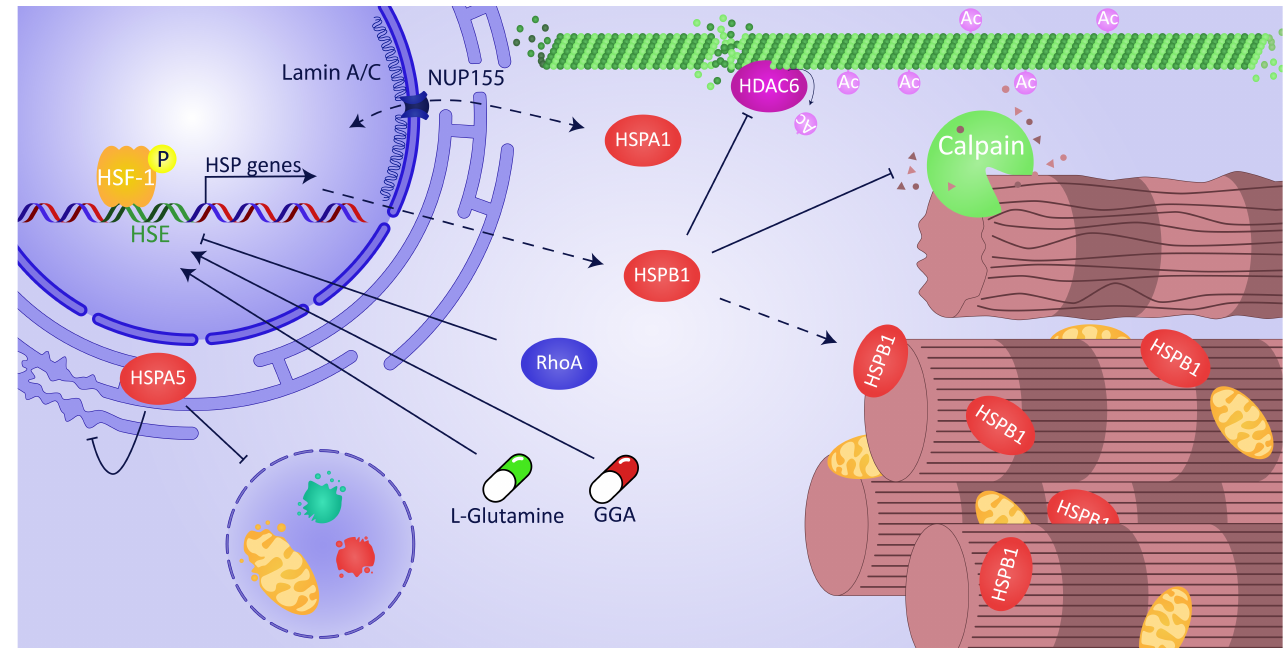
Figure 1. Overview of cardioprotective actions of heat shock protein (HSP) function in atrial fibrillation (AF). Heat Shock Factor 1 (HSF1), the central regulator of the heat shock response (HSR), trimerizes and is phosphorylated upon activation while being transported to the nucleus where it binds to the heat-shock-responsive DNA element (HSE) of HSP genes, including HSPB1 . The binding of HSF1 to HSE and sequential expression of HSPs is boosted by geranylgeranylacetone (GGA) and L-glutamine but attenuated by active Ras homolog gene family member A (RhoA). Within the cytosol, HSPB1 inhibits HDAC6-induced microtubule degradation by calpain. Furthermore, HSPB1 has a protective function by direct binding to the myofibrils and shielding them from degradation. HSPA5, located in the endoplasmic reticulum (ER), reduces ER stress and inhibits AF-induced autophagy. The export of mRNA HSPA1 and import of protein HSPA1 via NUP155 is directly influenced by mutations in lamin